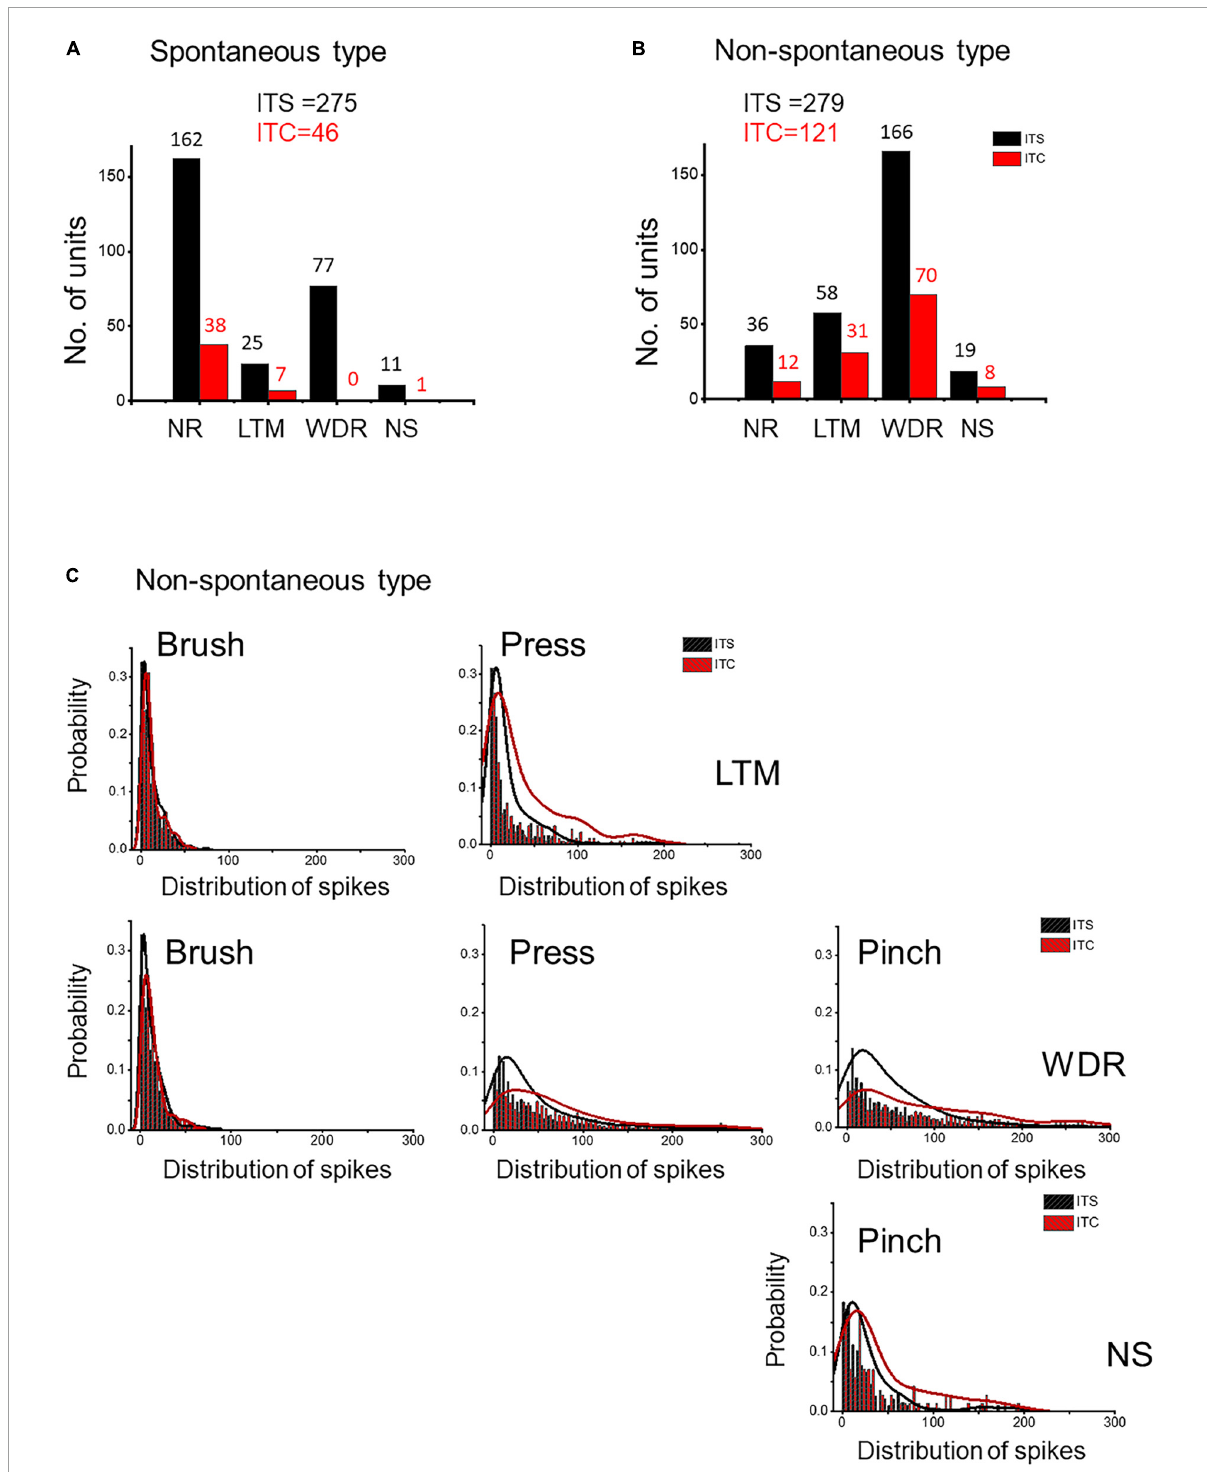
FIGURE6 Evidence for neuronal hyperexcitability or sensitization in spared spinal dorsal horn neurons 7 days after ITS or ITC. MEA recording and analysis of spontaneous type (A) and non-spontaneous type (B) of the three classes of spinal dorsal horn units following ITS and ITC. (C) Probability of frequency distribution of spike responses in LTM, WDR, and NS units to brush, pressure, and pinch stimuli in the spared non-spontaneous type following ITS or ITC. The frequency of spike responses of all three classes of dorsal horn neurons is stimulus intensity-dependent, and ITC group shows more high-frequency spike discharges than ITS group when stimulated by high-intensity mechanical stimuli (pressure and pinch) to both WDR and NS as well as